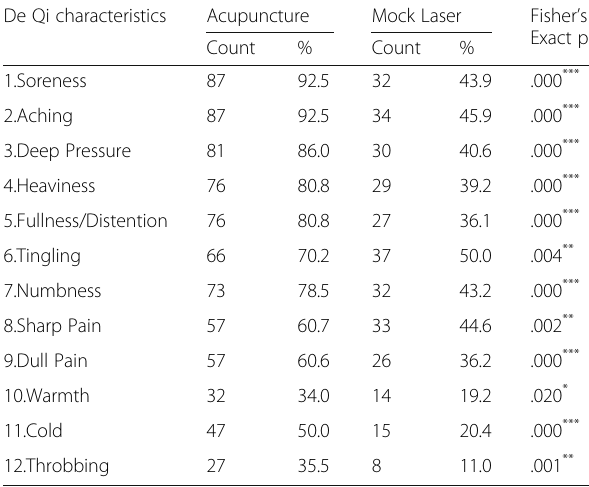
Table 2 Comparison of the frequency of individual De Qi characteristics between the two study groups De Qi characteristics